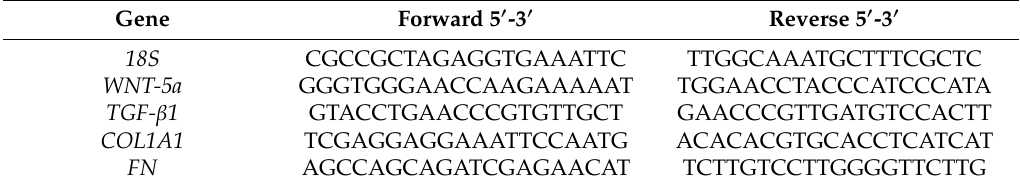
Table 2. Sequences of primers used for gene expression